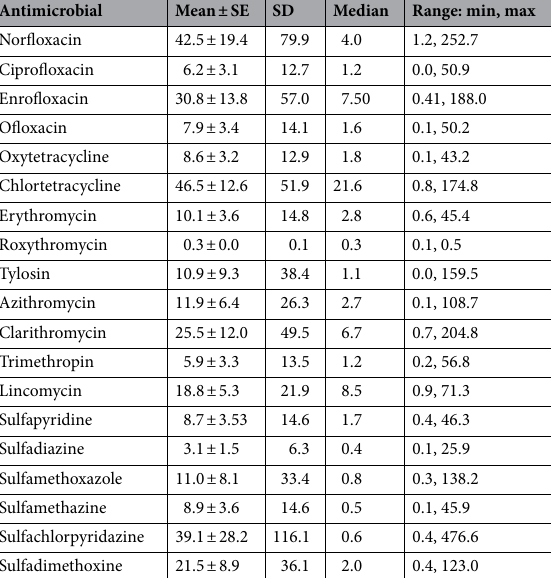
Table 1. Summary statistics (arithmetic mean ± standard error, standard deviation (SD), median, and range: minimum (min) and maximum (max)) for antimicrobial concentrations (ng/L) in water samples across sites analyzed in 2018 (n = 17).